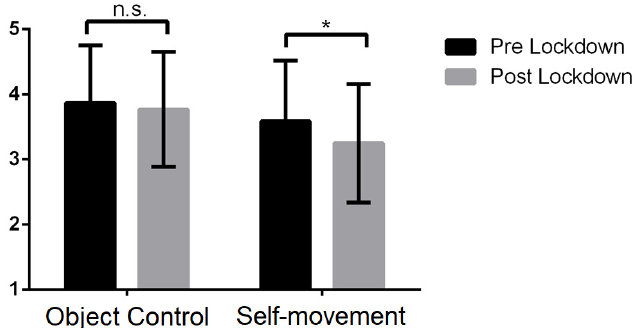
Figure 2. Comparison of PMC (object control and self-movement) pre- and post-lockdown. n.s. means no significant differences, whereas * means significant differences ( p < 0.05).